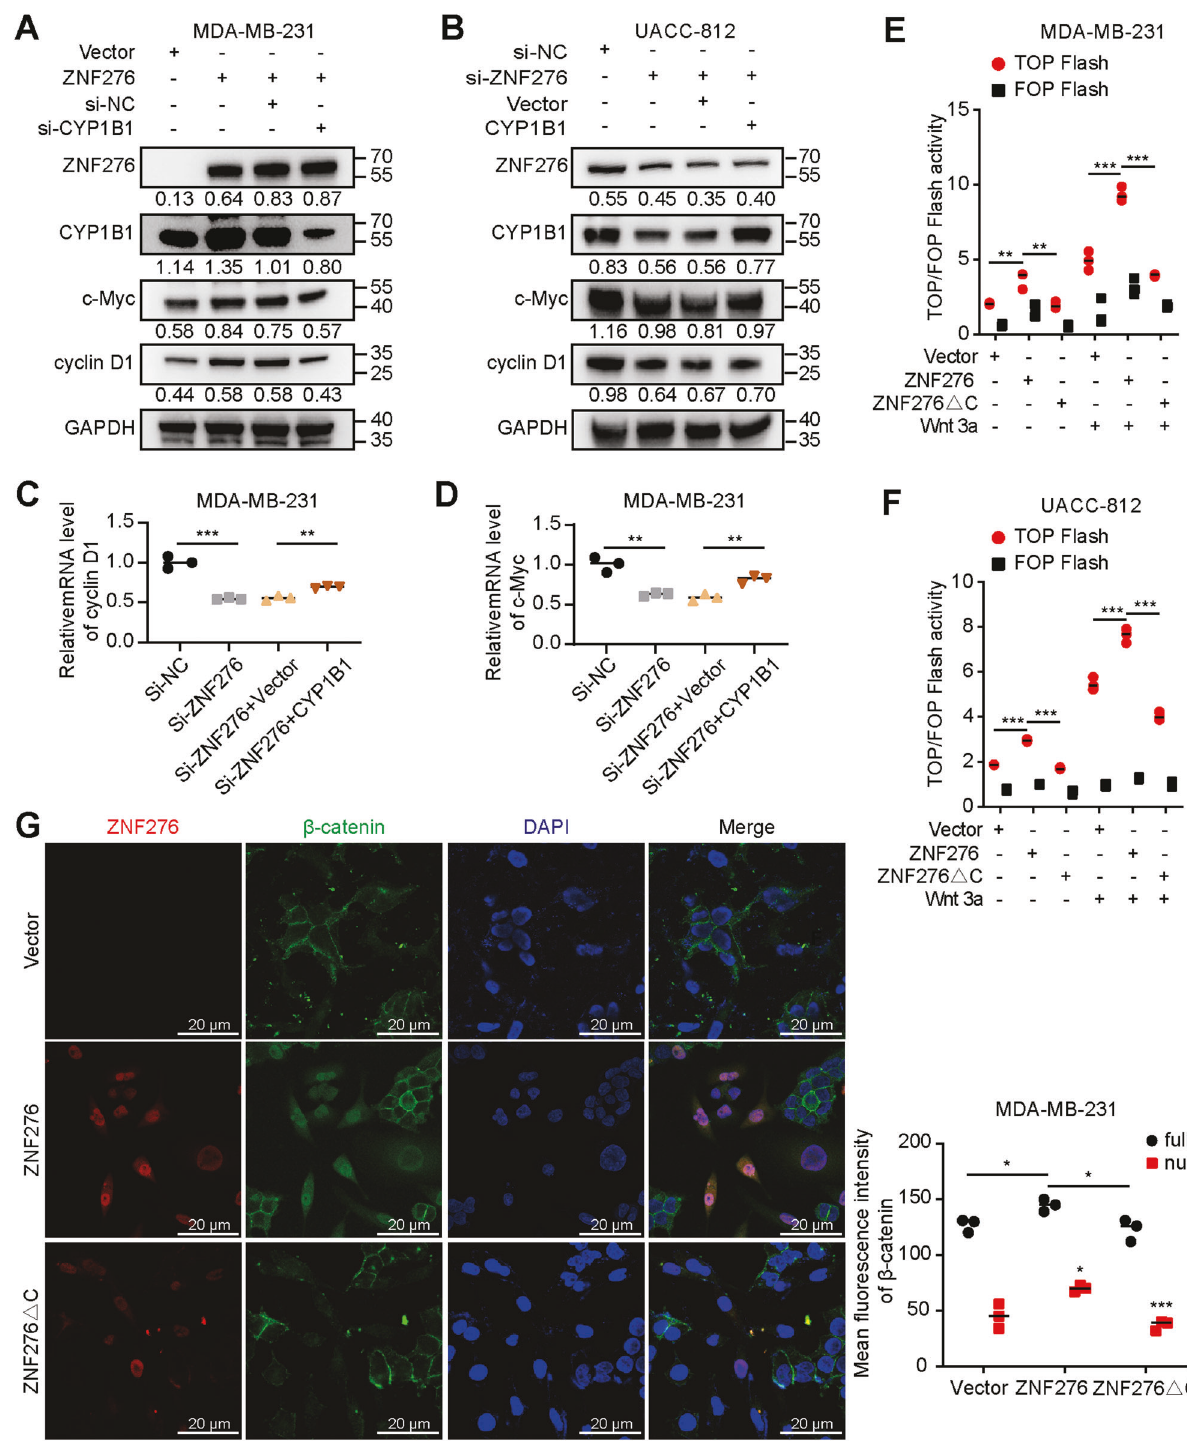
Fig. 5 ZNF276 activates the Wnt/ β -catenin signaling by regulation of CYP1B1. A , C Western blotting ( A ) and RT-qPCR ( C ) analysis revealed that silencing of CYP1B1 inhibited the expression of c-Myc and Cyclin D1 enhanced by ZNF276 overexpression in MDA-MB-231 cells. B , D Effects of ZNF276 knockdown and CYP1B1 overexpression on c-Myc and Cyclin D1 expression were analyzed in UACC-812 cells by western blotting ( B ) and RT-qPCR ( D ). E , F ZNF276 lacking C 2 H 2 domain inhibited the TOP Flash activity enhanced by the intact ZNF276 with wnt3a activation in MDA-MB-231 ( E ) and UACC-812 ( F ) cells. G Endogenous β -catenin expression and distribution was observed by immuno fl uorescence in MDA-MB-231 cells transfected with intact ZNF276 or ZNF276 lacking C 2 H 2 domain plasmid. Nuc nuclear. Bar = 20 µm. * p < 0.05; ** p < 0.01; *** p < 0.001.